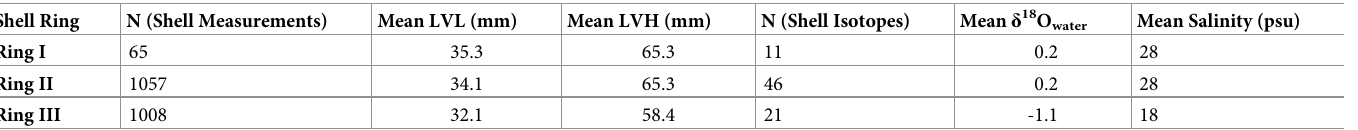
Table 2. Descriptive statistics for oyster measurements and oxygen isotope